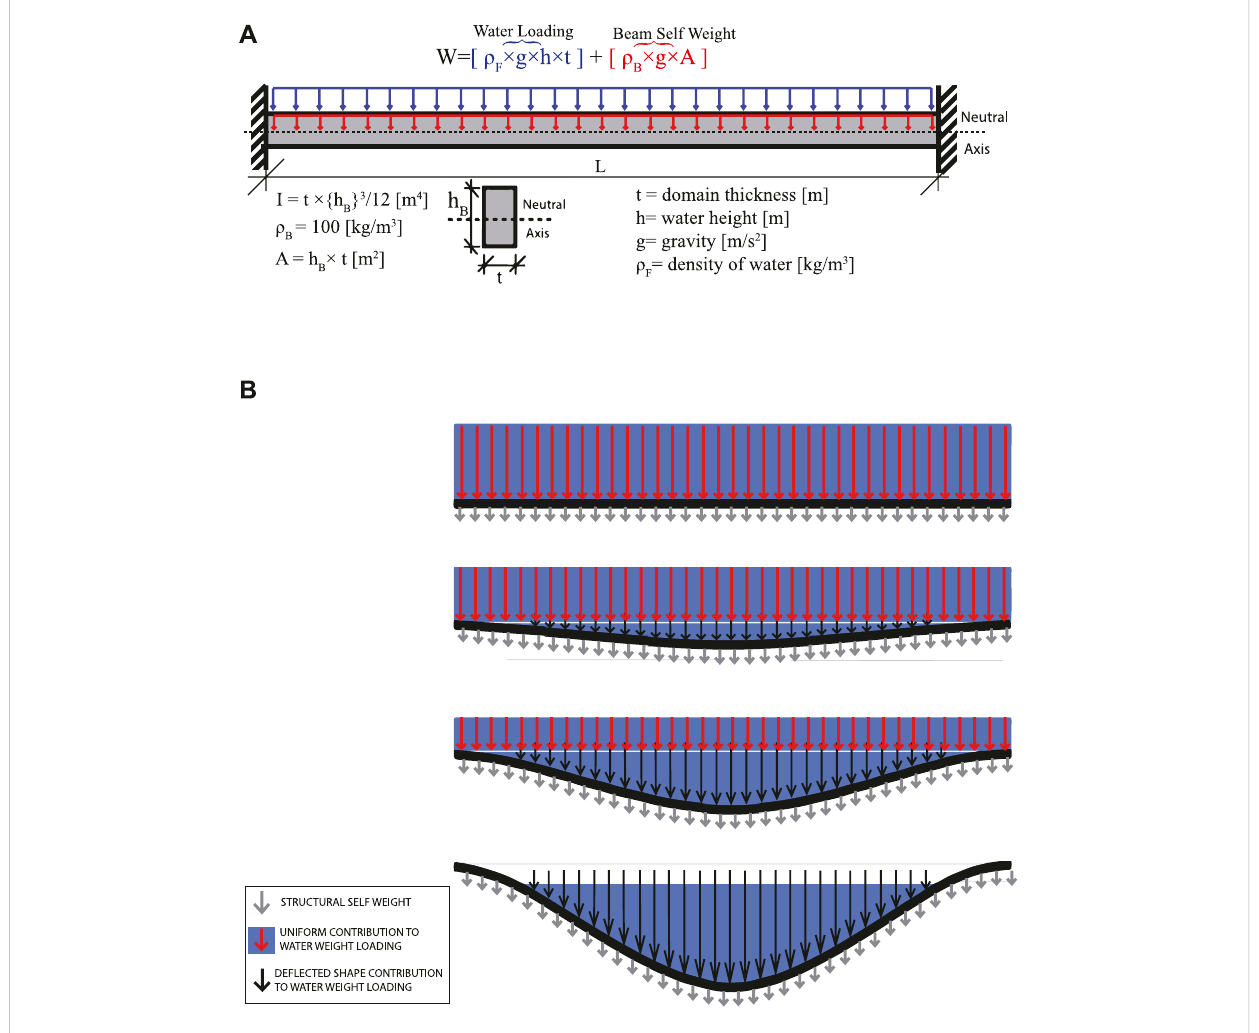
FIGURE 8 (A) Beam with properties E, I, L, A, ρ B , within a domain t m wide, topped with water h m deep, under uniform gravity loading g, (B) Change of loading contribution with displacement of beams under shifting water.